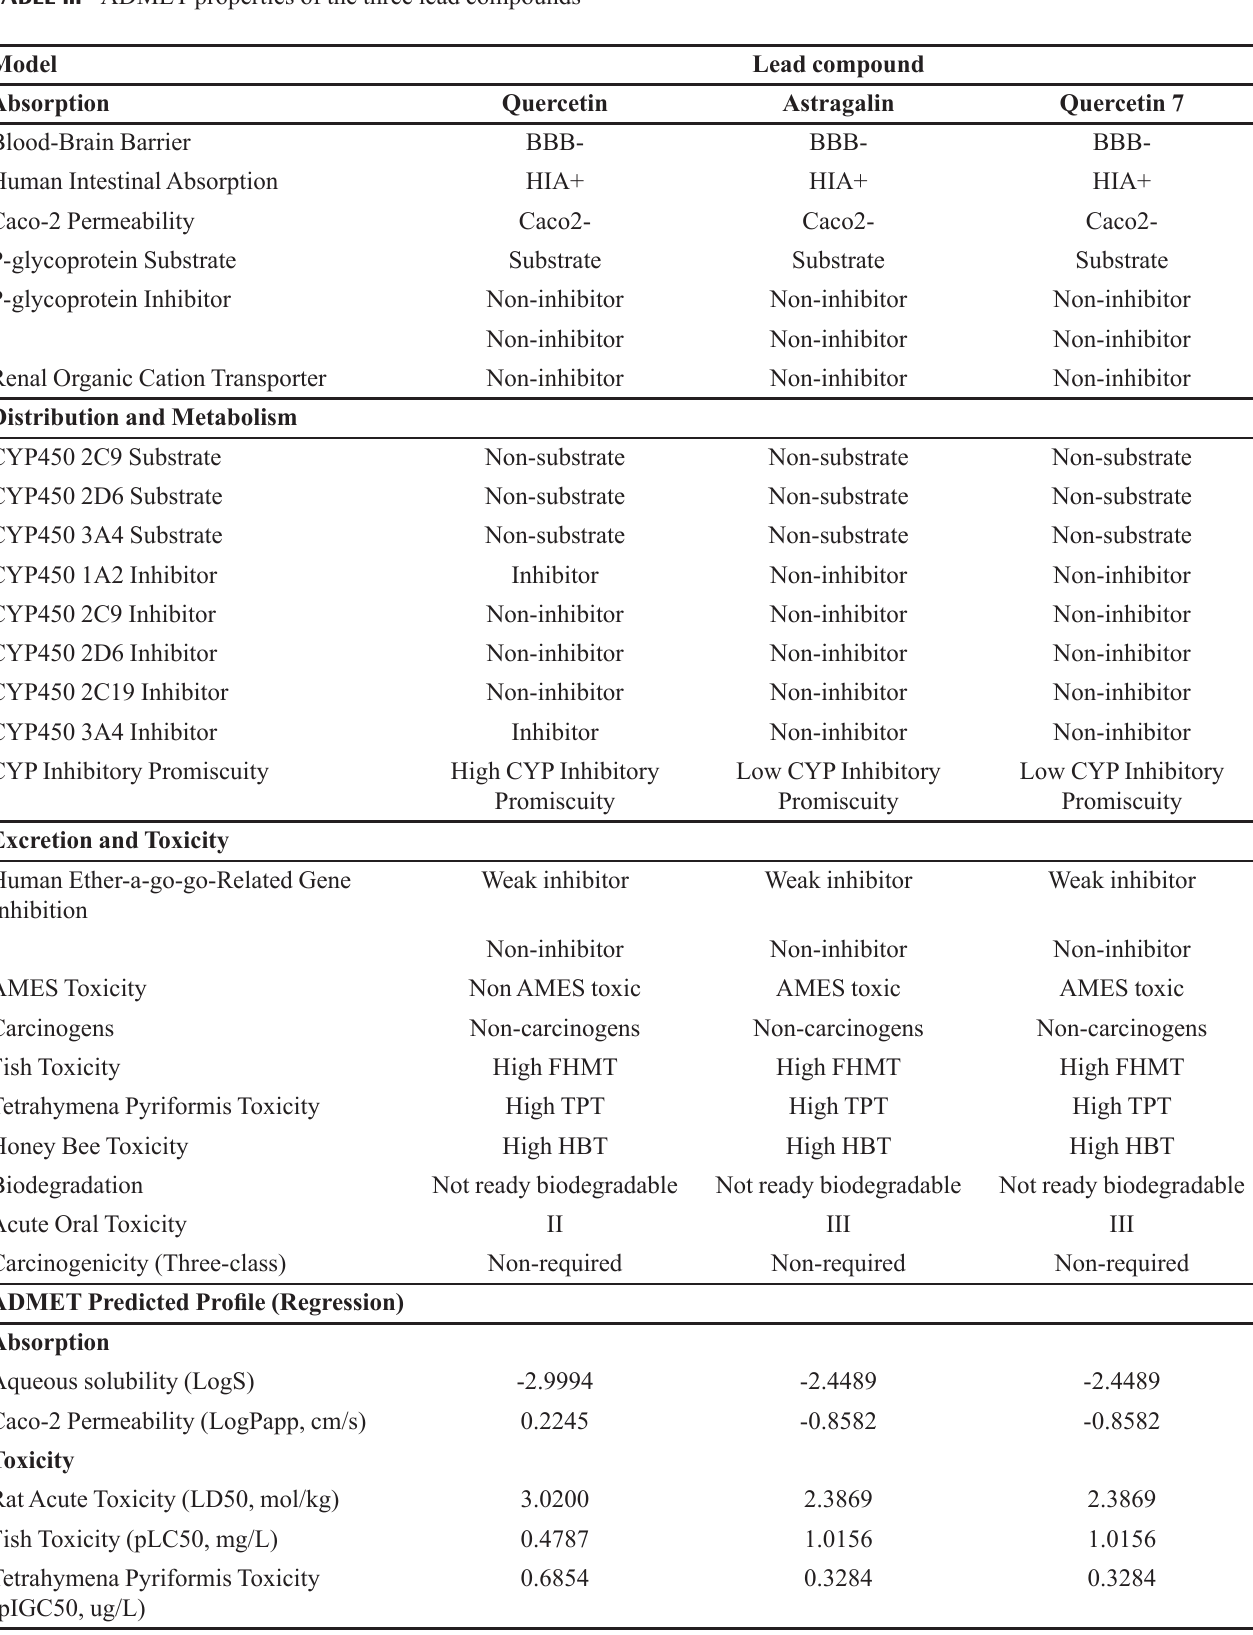
TABLE III - ADMET properties of the three lead compounds